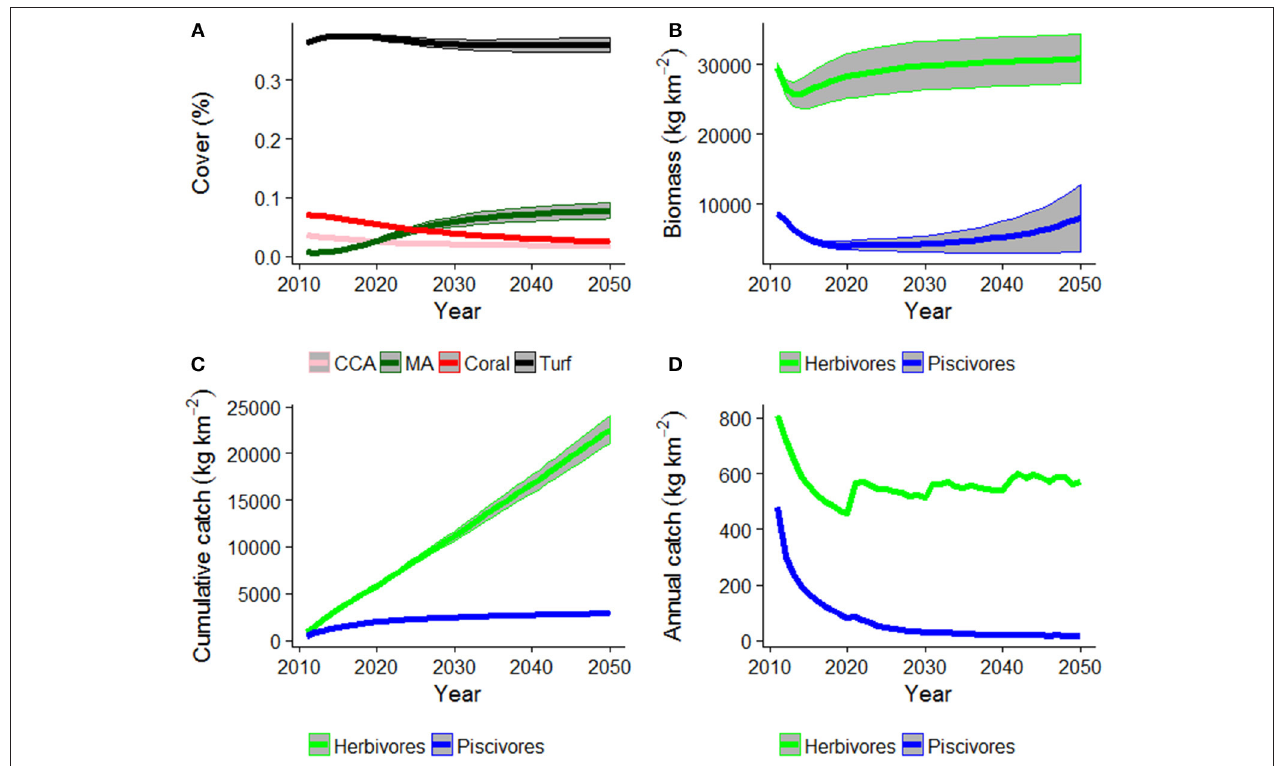
FIGURE 3 | HIReefSim model estimated trajectories of (A) cover of crustose-coralline algae (CCA), macroalgae (MA), coral, and turf algae, (B) fish biomass, (C) fish cumulative catch, and (D) annual catches under the Current Management scenario. Shaded area is ± 1 standard error of the